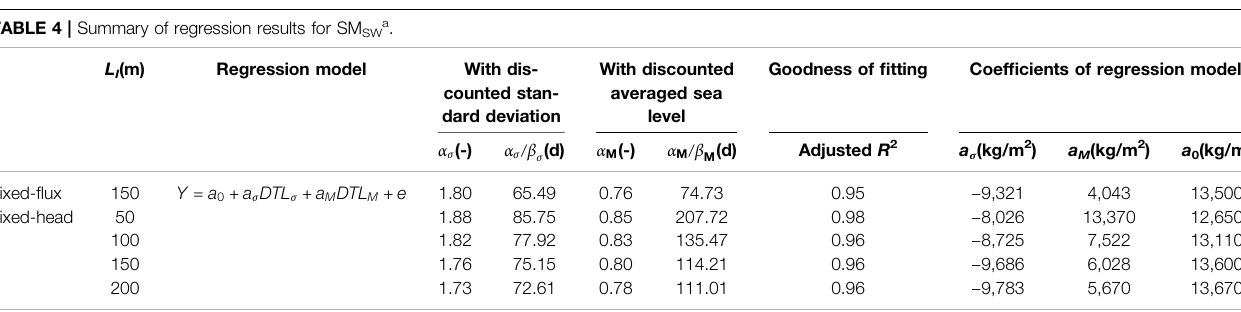
TABLE 4 | Summary of regression results for SM SWa .